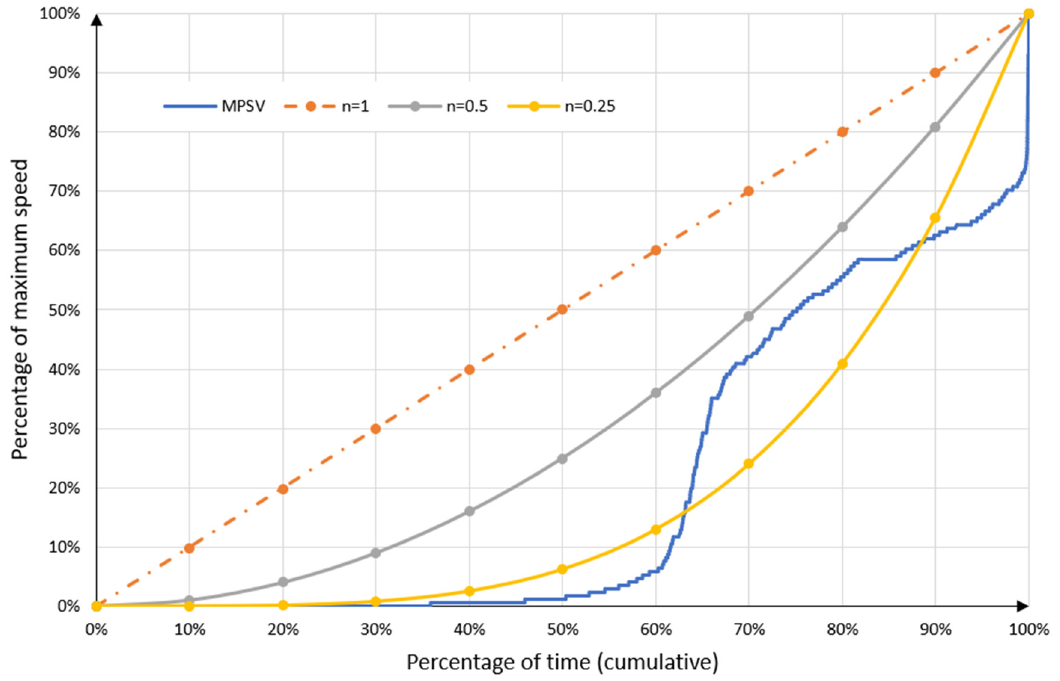
Figure 7. Speed distribution with time for MPSV.